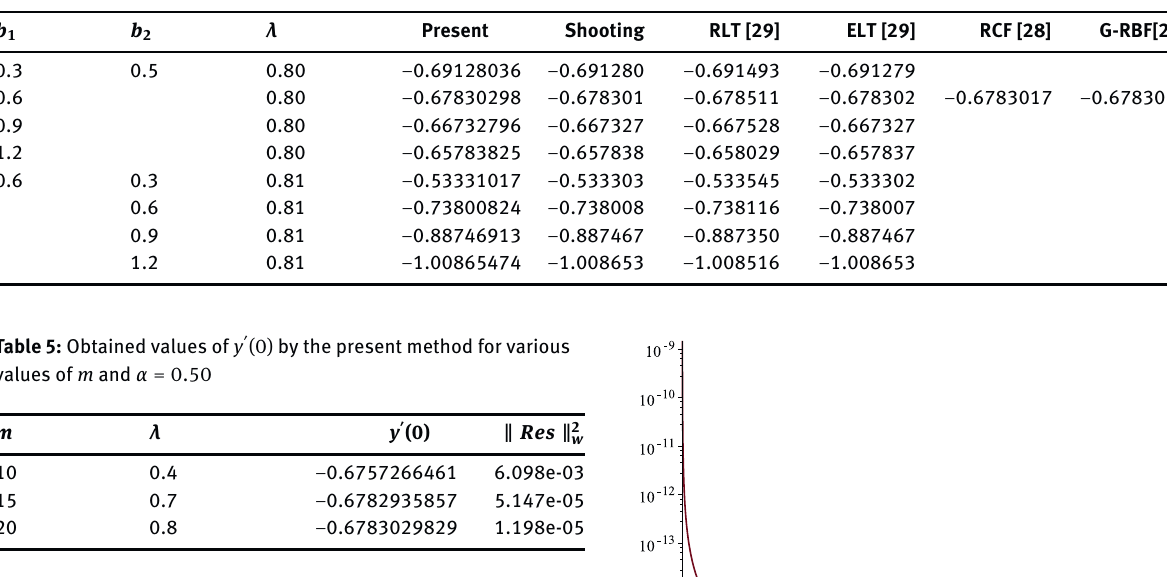
Table 6: Obtained values of y ′ (0) by the present method for various values of α and m = 20 α